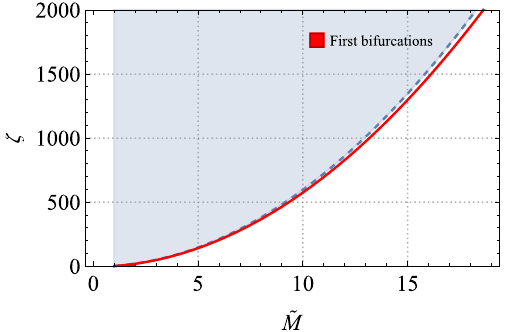
Fig. 3 The red line shows the first bifurcations of the scalar field and the shaded region presents the unstable regions based on the condition (21) from integral of the